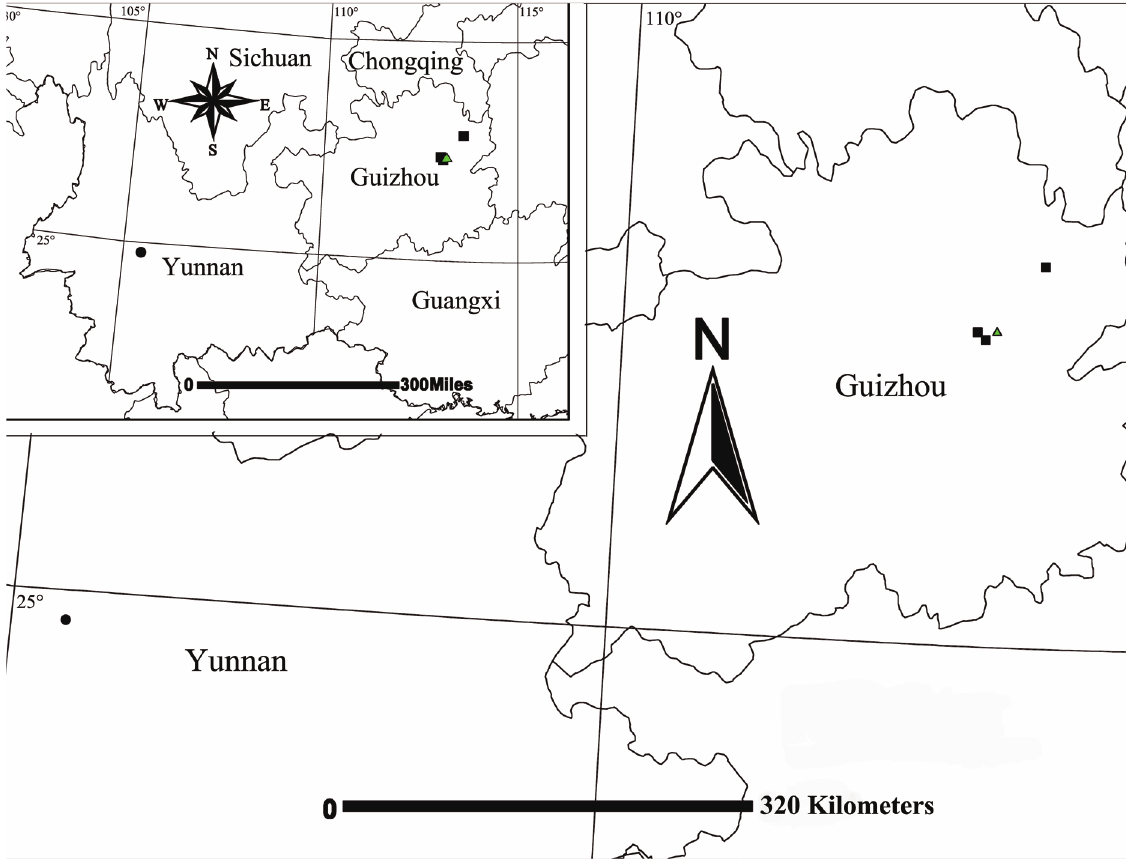
Fig. 7. Distribution records of Mimetus bucerus sp. nov. (▲), M. lingbaoshanensis sp. nov. (●) and M. yinae sp. nov.